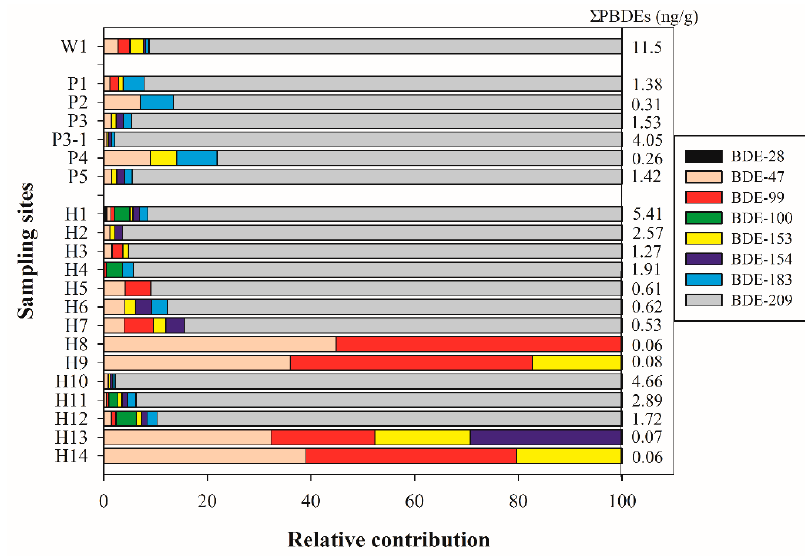
Figure 3. Compositional pattern of PBDEs in sediment/sludge samples collected from rivers (P1–P5), Chaohu Lake (H1–H14), and STP effluents (W1). Chaohu Lake (H1–H14), and STP effluents